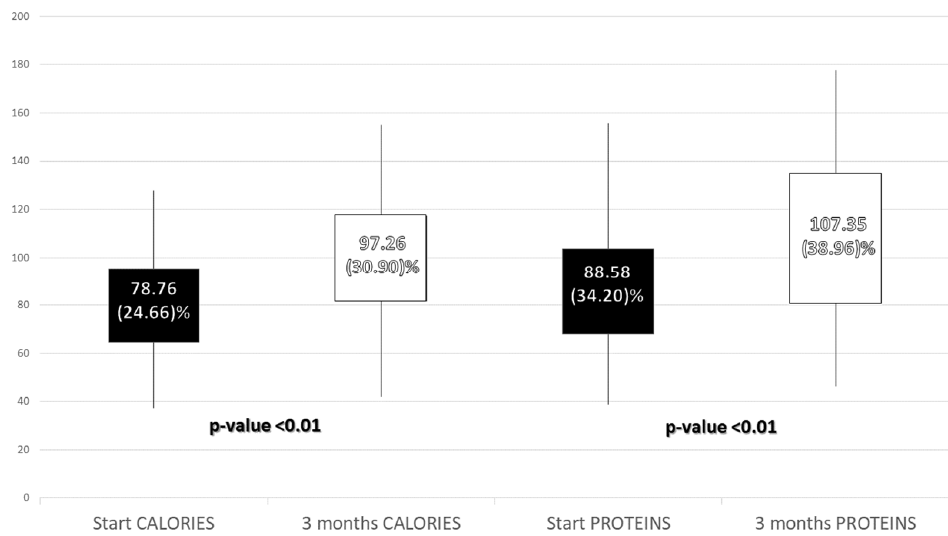
Figure 3. Percent of adjustment to caloric and protein requirements before and 3 months after the intervention.